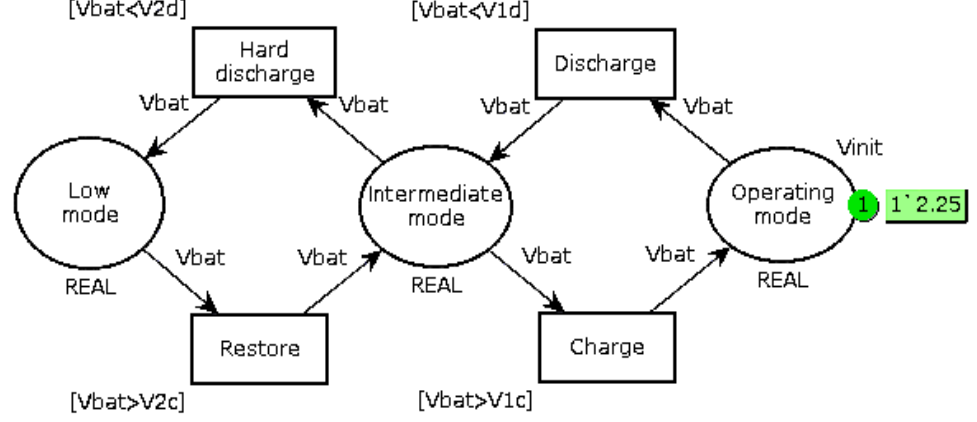
Figure 5. Proposed operation of the system in three modes, depending on the cell voltage.